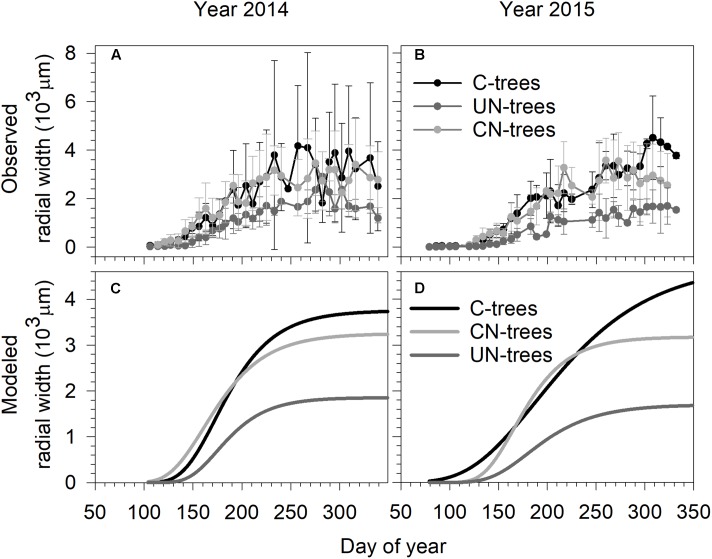
Observed (A,B) and Gompertz modeled radial growth (C,D) of sweetgum under control-C, canopy N addition-CN and understory N addition-UN treatments during the 2014 and 2015 growing seasons in Central China. Vertical bars represent the standard deviation among trees.